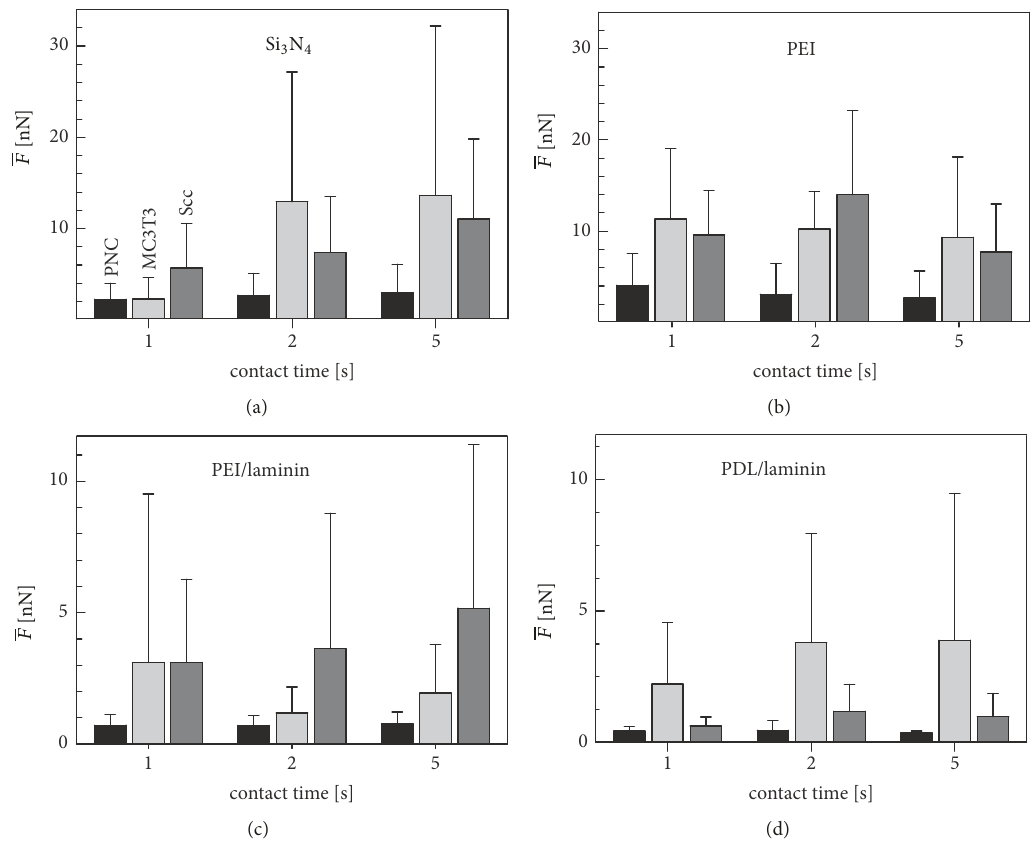
Figure 2: Mean measurement MDFs ( 𝐹 𝑛,𝑠,𝑡 ) of the three cell types, PNCs (black, n=12), MC3T3 (light gray, n=14), and Scc (dark gray, n=10), on the silicon nitride reference surface for contact times of 1, 2, and 5 seconds (a). 𝐹 𝑛,𝑠,𝑡 on PEI, PEI/laminin, and PDL/laminin surfaces for the same cells (PNCs, n=10; MC3T3, n=9; Scc, n=9) are presented in (b), (c), and (d). The measurement data are given in the supplementary material (Table S1). The statistical differences in the characteristicMDF behaviorof the cell types were analyzed by two-way variance analyses (Table